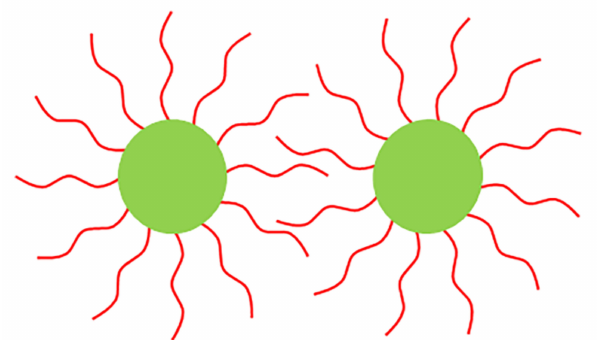
Figure 9. Schematic diagram of steric repulsion produced by the surfactant layers on the WO 3- x CNDs. Adapted with modification from Refs. [25,45].